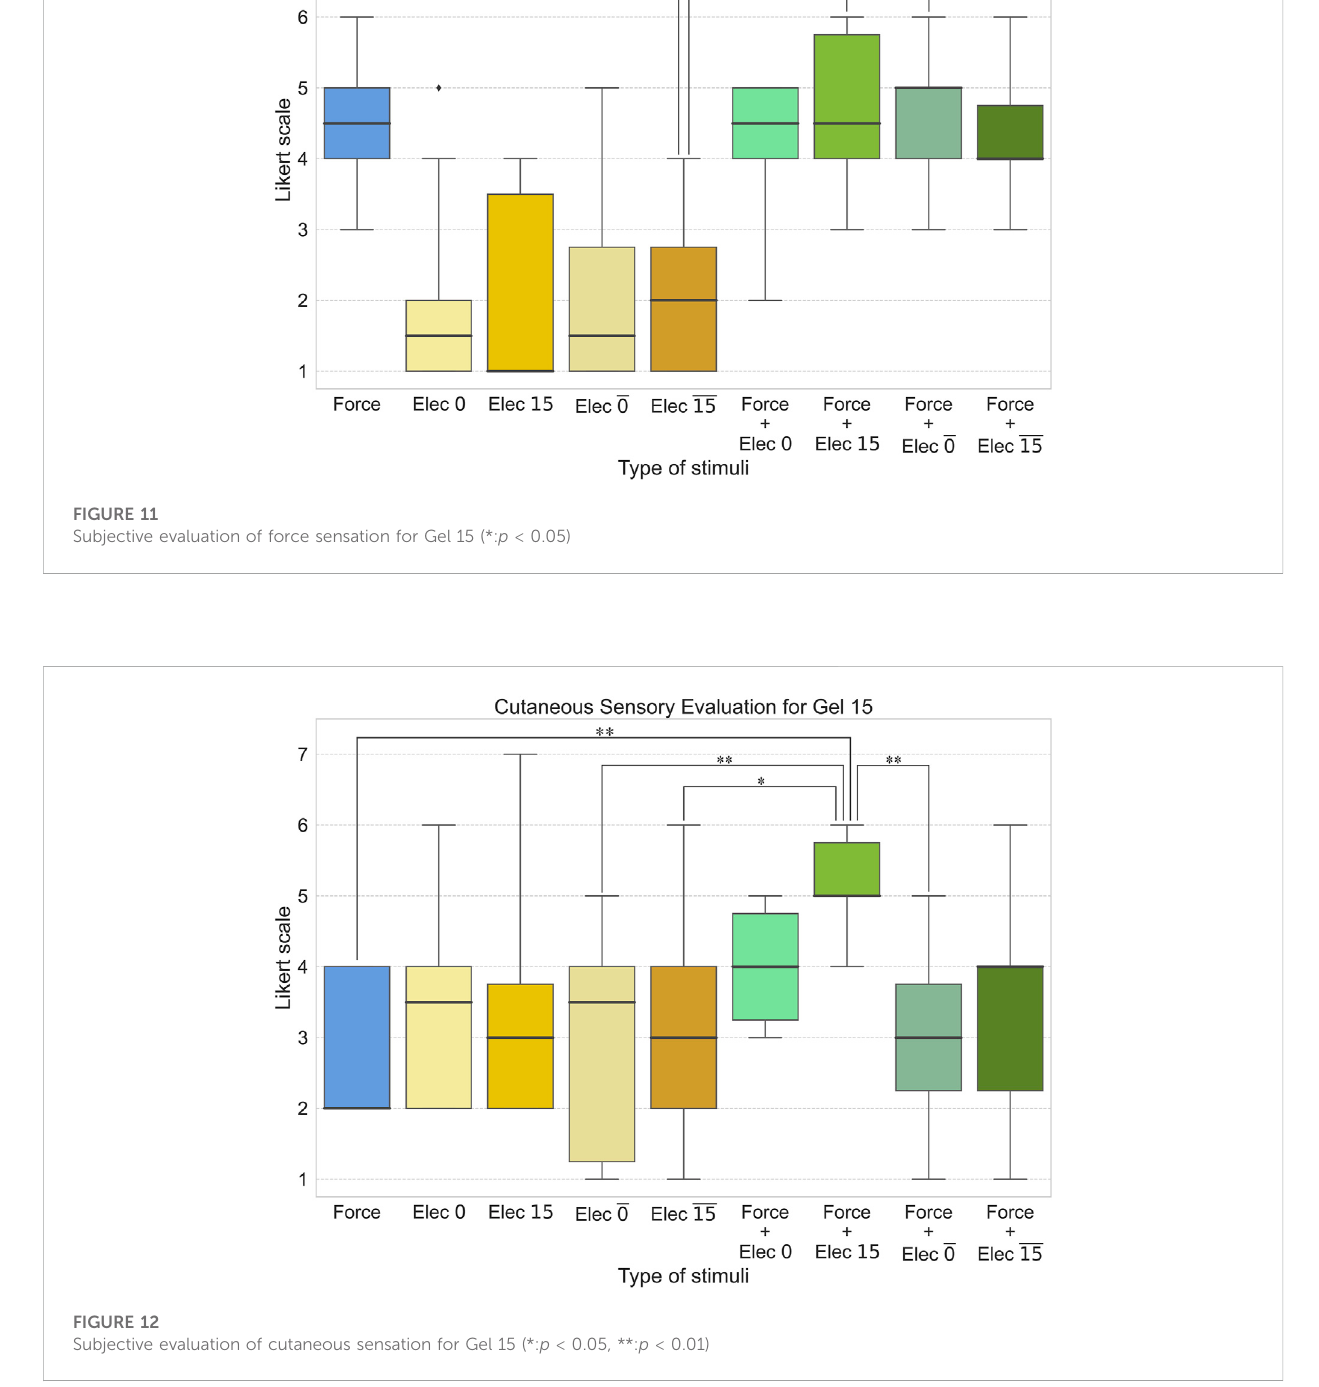
the force stimulus plus Elec 0, which reproduced the contact area of Gel 0, was evaluated as a signi fi cantly more realistic cutaneous sensation for Gel 0 than all other conditions, indicating the effectiveness of the proposed method. For Gel 15, which is a